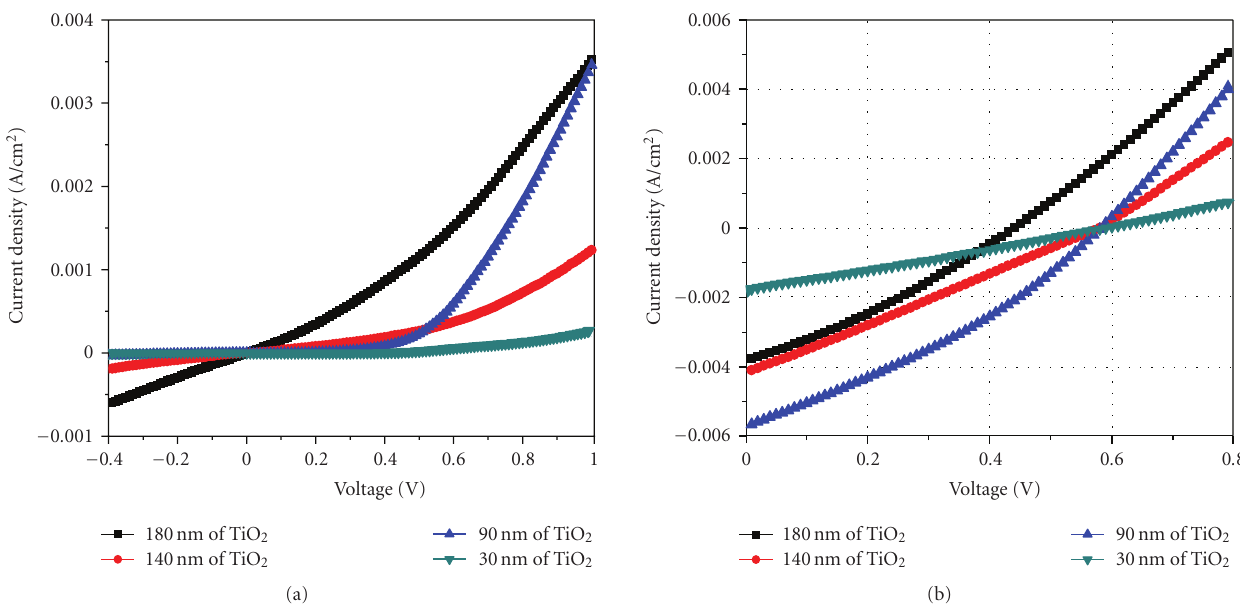
Figure 4: (a) I–V characteristics of device in dark condition used di ff erent thickness of TiO 2 to construct the TiO 2 /G-PEDOT nanocomplex anode. (b) I–V characteristics measured under white illumination (Xe lamp, 80mW/cm 2 ). Devices’ performance: (square) Jsc = 3.8mA/cm 2 Voc = 0.44 V FF = 0.30 η = 0.64%, (circles) Jsc = 4.1mA/cm 2 Voc = 0.59V FF = 0.26 η = 0.78%, (up-triangle) Jsc = 5.7mA/cm 2 Voc = 0.59 V FF = 0.33 η = 1.38%, and (down-triangle) Jsc = 1.78 mA/cm 2 Voc = 0.60 V FF = 0.26 η = 0.35%.